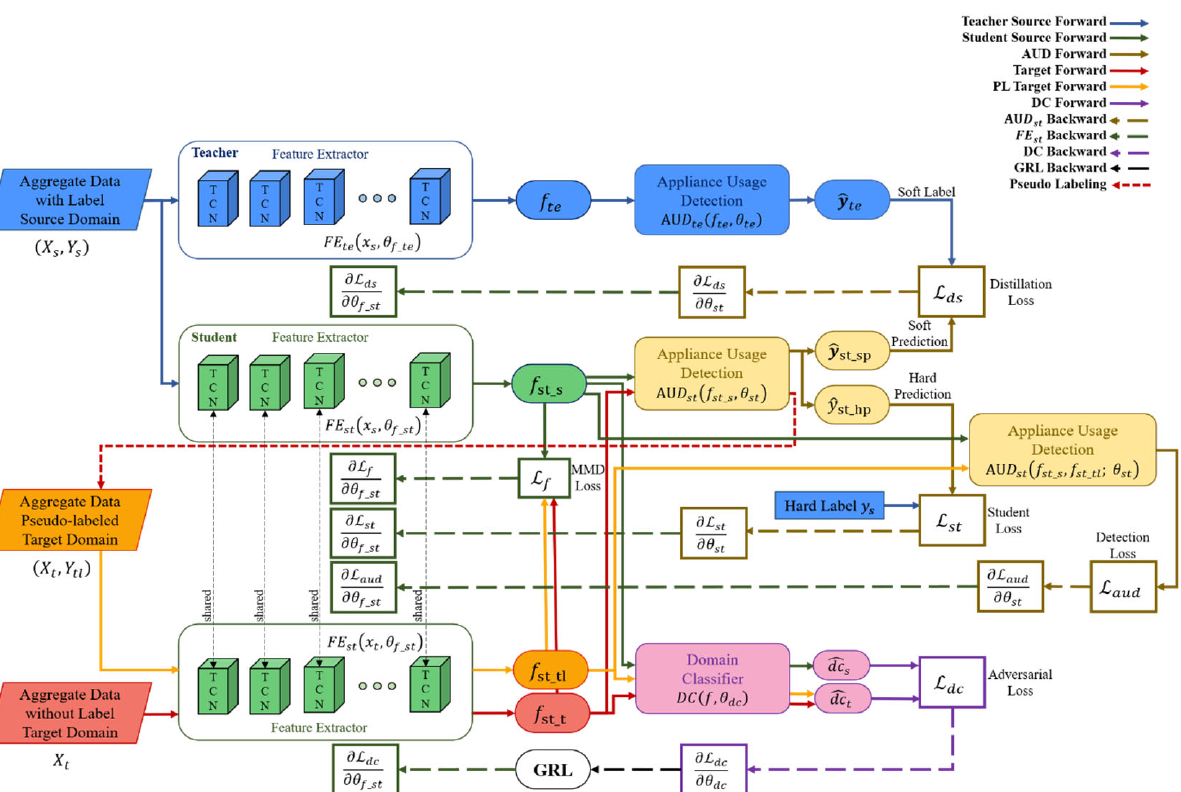
Figure 1. A detailed overall configuration diagram of the proposed semi ‐ supervised domain adaptation for multi ‐ label classification on nonintrusive load monitoring.